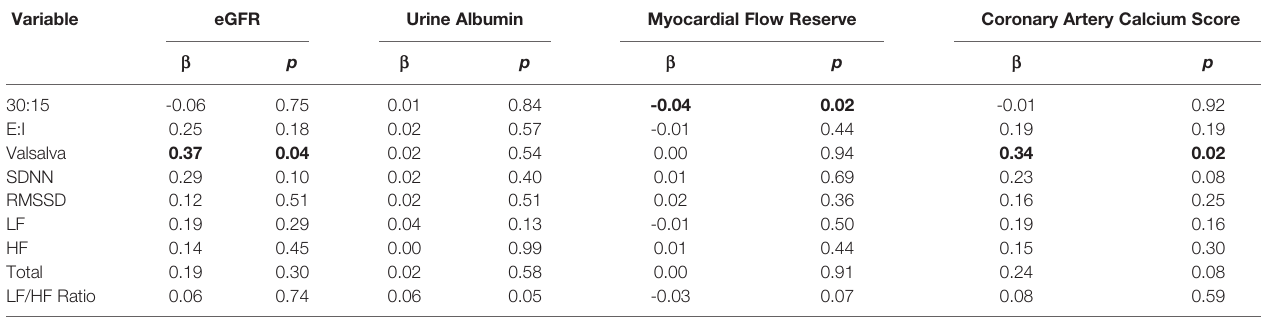
TABLE 3 | Associations between cardiovascular autonomic function at baseline and changes in heart and kidney function. Variable